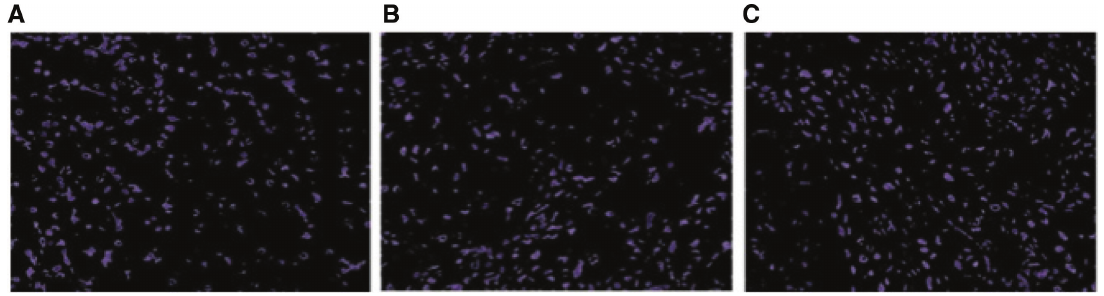
Figure 5: Segmented